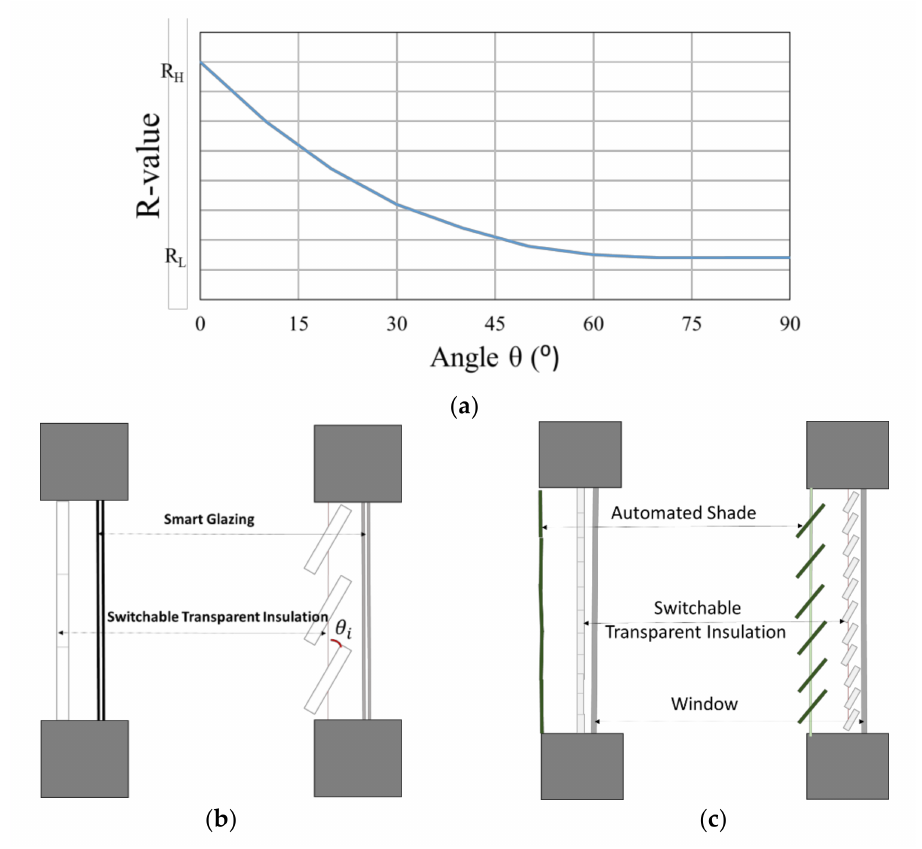
Figure 1. ( a ) The variation for SIS as a function of the rotating angle, θ , with configurations for SIS-integrated windows suitable for ( b ) smart glazing and ( c ) standard glazing